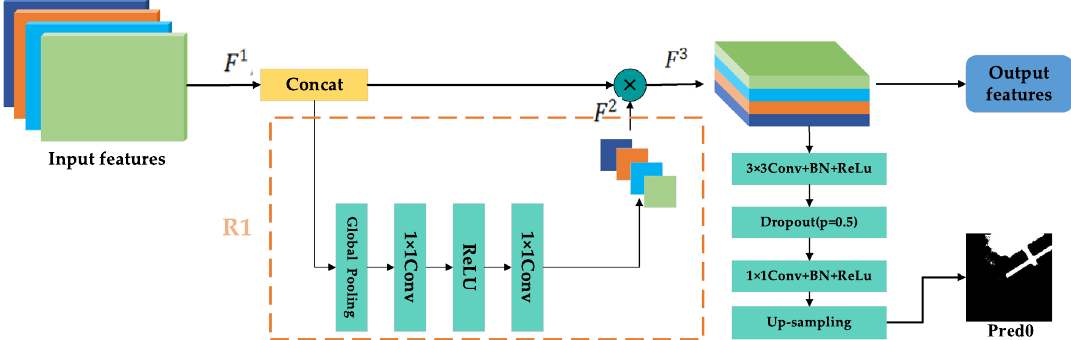
Figure 3. The structure of MSFA (created by ‘Microsoft Office Visio 2013’ url: https:// www. micro soft. com/ zh- cn/ micro soft- 365/ previ ous- versi ons/ micro soft- visio-